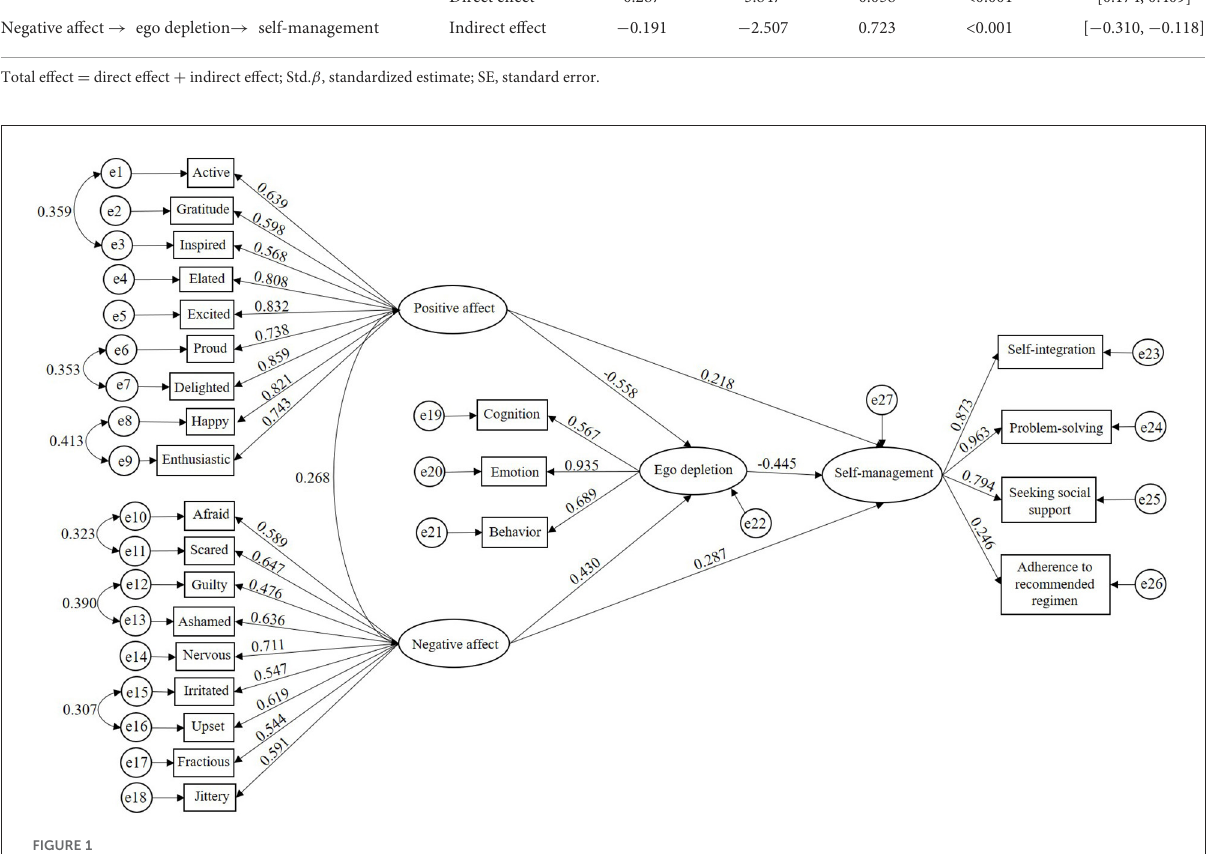
to − 0.118, p < 0.001). The absolute value of the ratio of the suppressing effect to the direct effect was